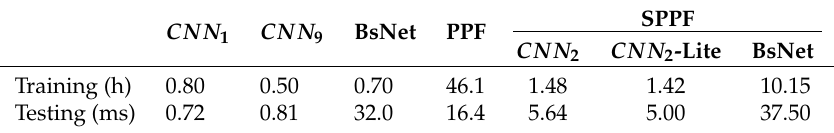
Table 6. Time consumption in training and testing deep models on the Pines